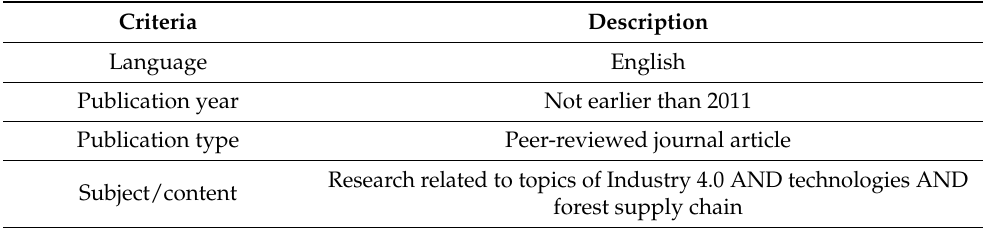
Table 1. Inclusion criteria to select papers in this